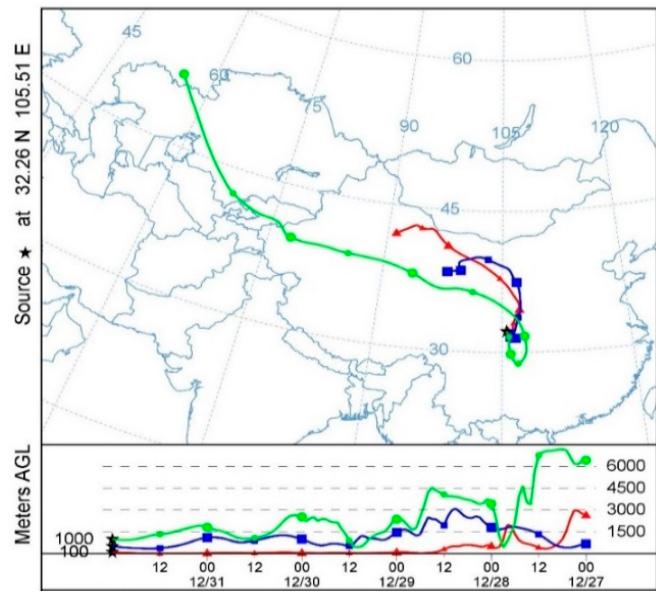
Figure 8. The computed back trajectory for the 120-h period ending 0000 UTC on 1 January 2018 in Guangyuan, showing the meters above ground level (AGL) that include the air mass at 1000 m (green line), the air mass at 500 m (blue line), and the air mass at 100 m (red line).